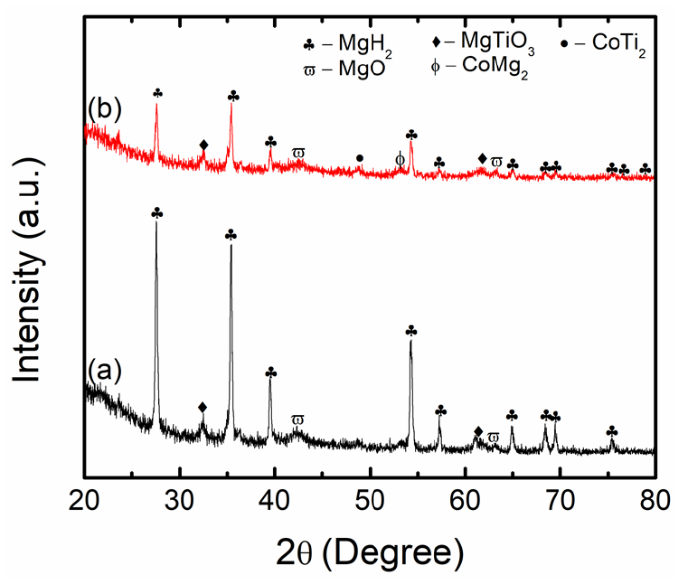
Figure 10. XRD patterns of ( a ) MgH 2 + 10 wt.% CoTiO 3 and ( b ) MgH 2 + 50 wt.% CoTiO 3 after the absorption process at 200 °C.